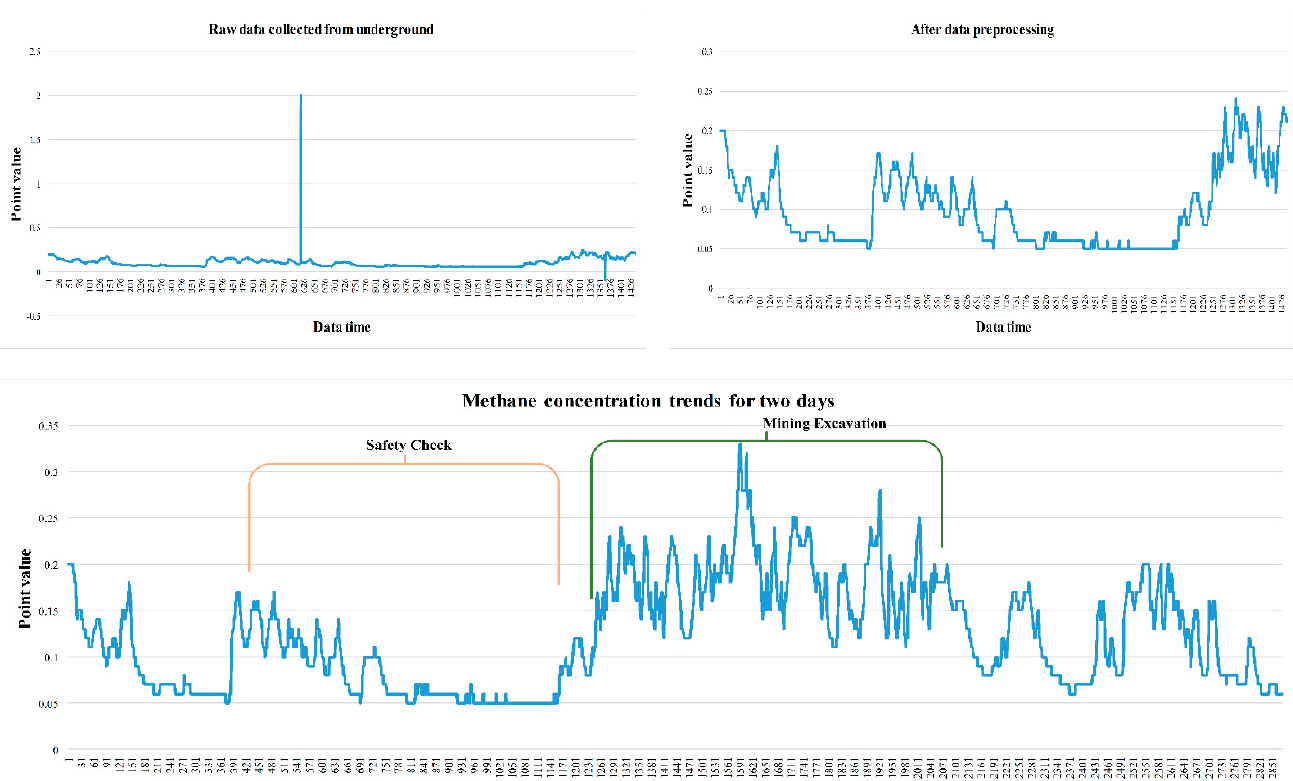
Figure 2. Methane concentration trends.